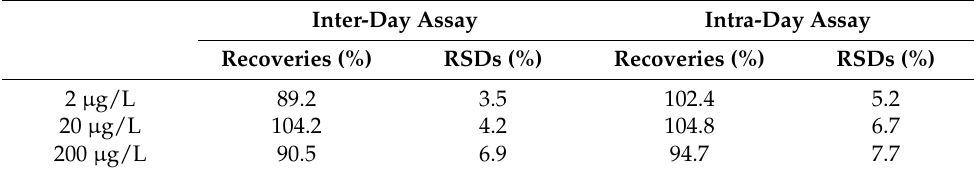
Figure 5. MRM chromatograms of TTX in procedural blank sample analyzed by UPLC-MS/MS with Table 4. Inter- and intra-day accuracy and a Waters ACQUITY UPLC BEH Amide column.